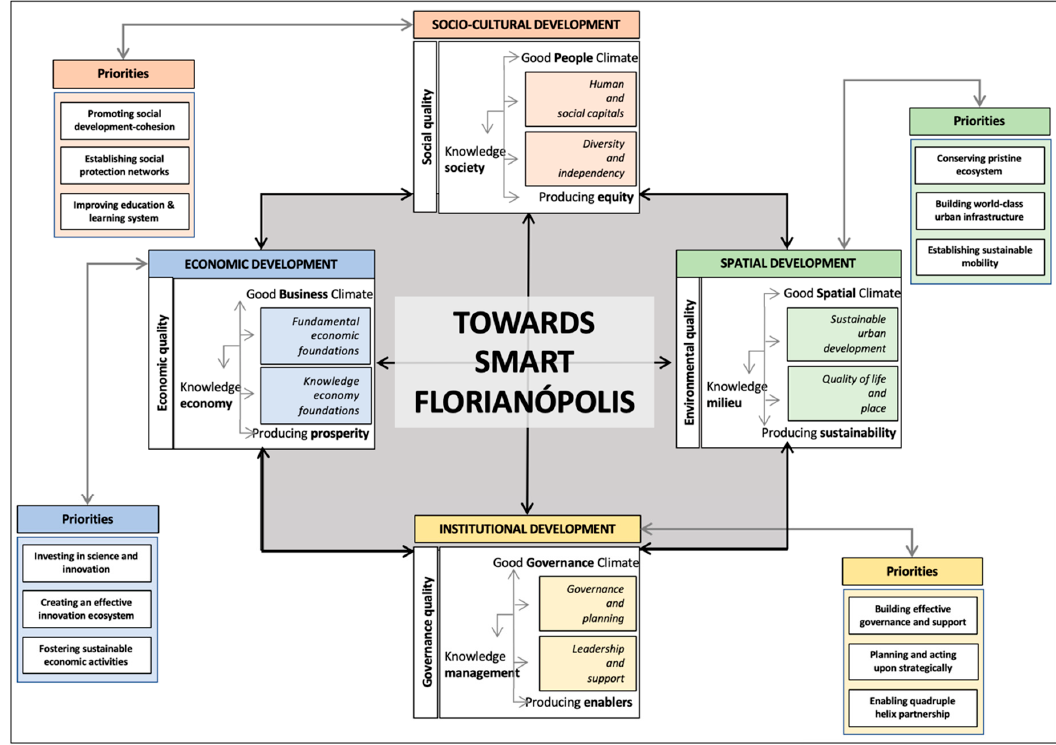
Figure 10. A framework for knowledge-based development of Florianópolis, derived from Reference